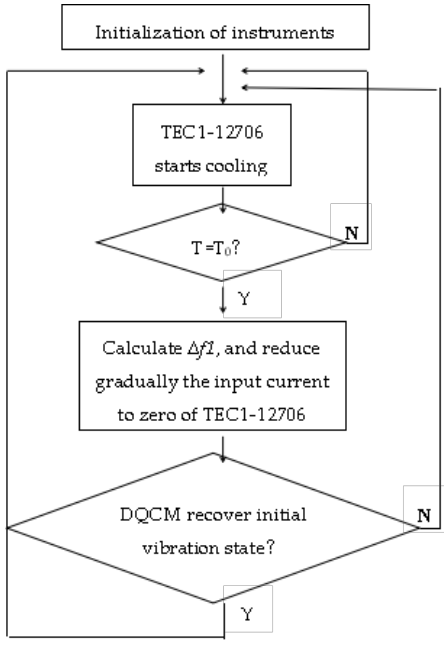
Figure 6. Work flow chart.